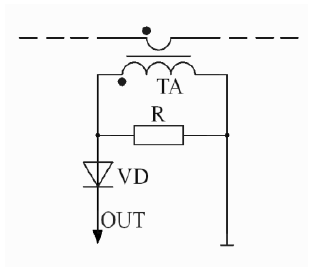
Figure 6. Inductor current sensor